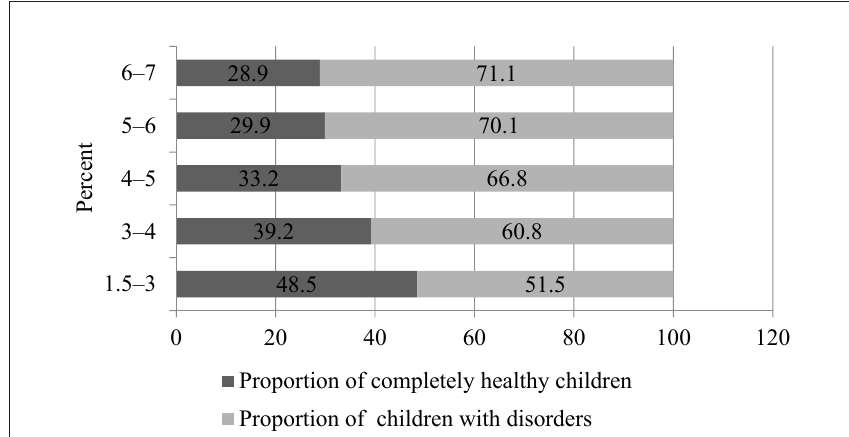
Figure 1. Percentage of completely healthy children by age